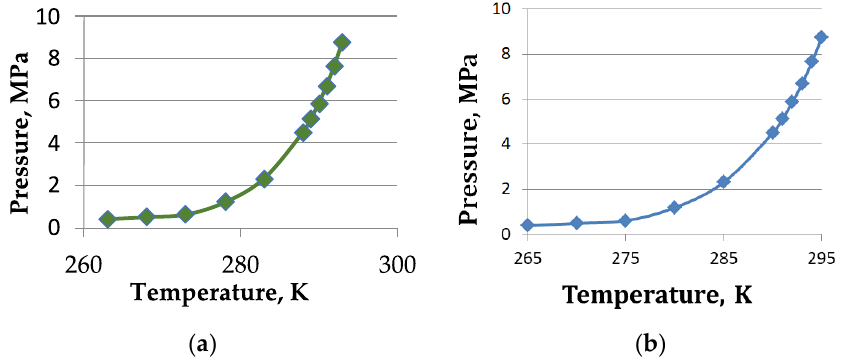
Figure 1. The equilibrium curve: ( a ) for methane hydrate; ( b ) for methane-propane hydrate.